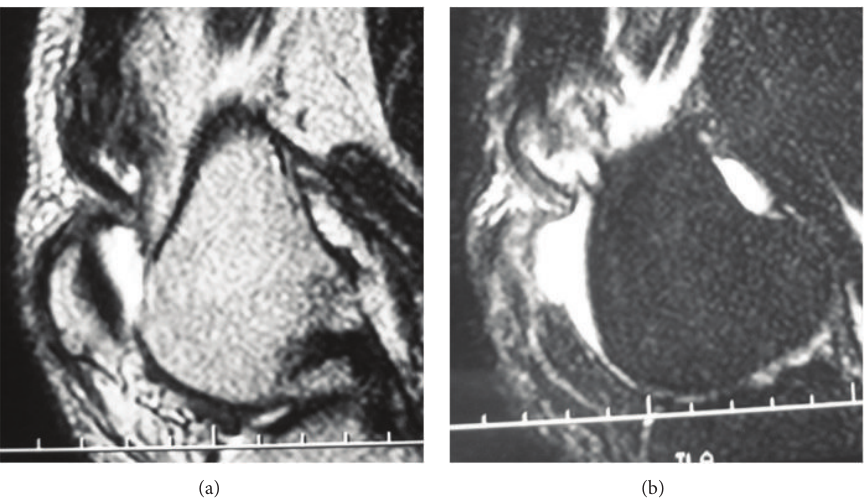
Figure 3: MRI findings. (a) A proton density-weighted image. Continuity of the quadriceps tendon to the patella was completely disrupted.